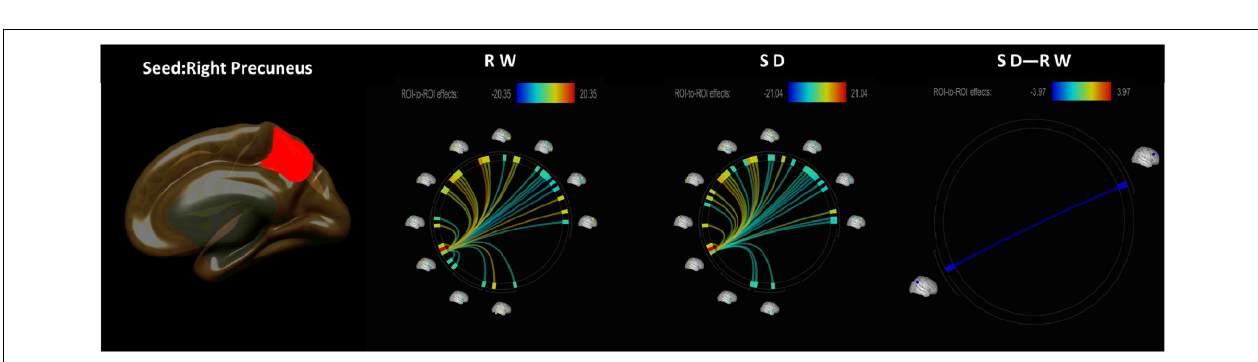
FIGURE 1 | ROI-to-ROI functional connectivity of the left precuneus during the RW, SD, and SD > RW conditions. False discovery rate-corrected ( p < 0.05) for ROI-to-ROI tests. ROI, region of interest; SD, sleep deprivation; RW, rested wakefulness.